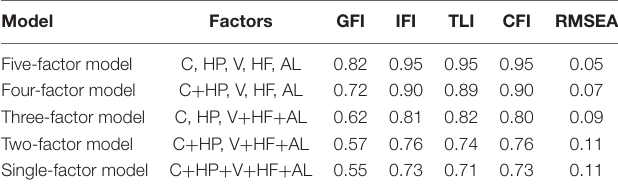
TABLE 2 | Results of confirmatory factor analysis.